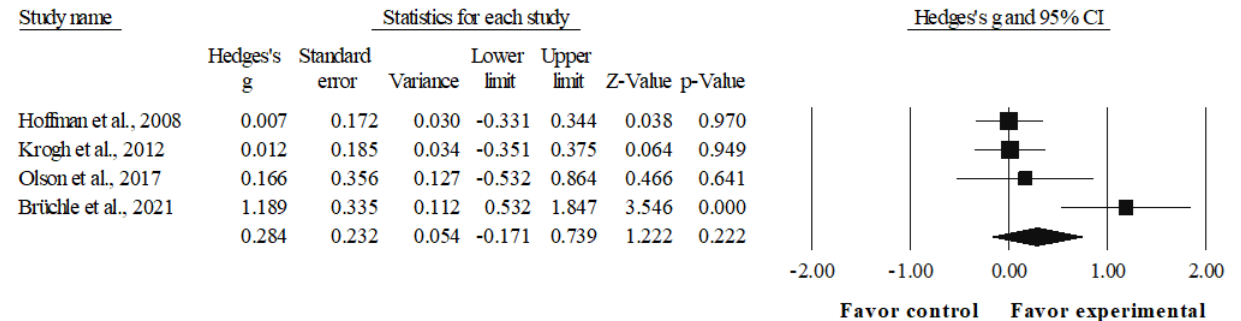
Figure 3. Forest plot for inhibition outcome. Values shown are effect sizes (Hedges’s g) with 95% confidence intervals. The size of the plotted squares reflects the statistical weight of the study. Black squares: individual studies. Black rhomboid: summary result.